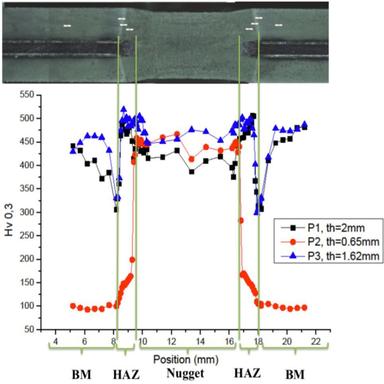
Hardness distribution along the spot weld joint assembly.